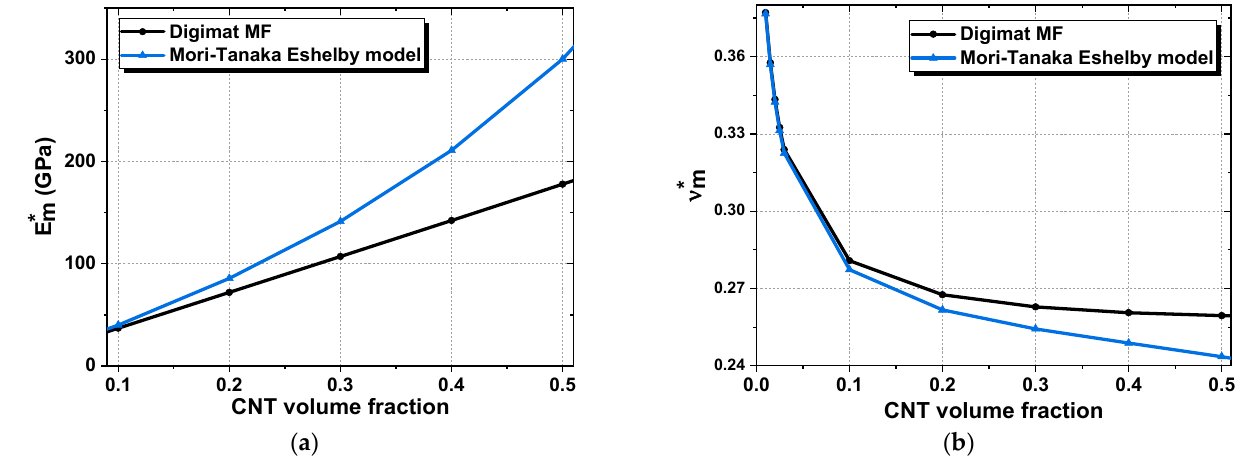
Figure 4. Effective elastic moduli of a matrix reinforced by randomly oriented nanofillers, a com- parison between Digimat MF and Mori–Tanaka scheme: ( a ) effective Young’s modulus E ∗ m ; and ( b ) effective Poisson’s ratio ν ∗ m .